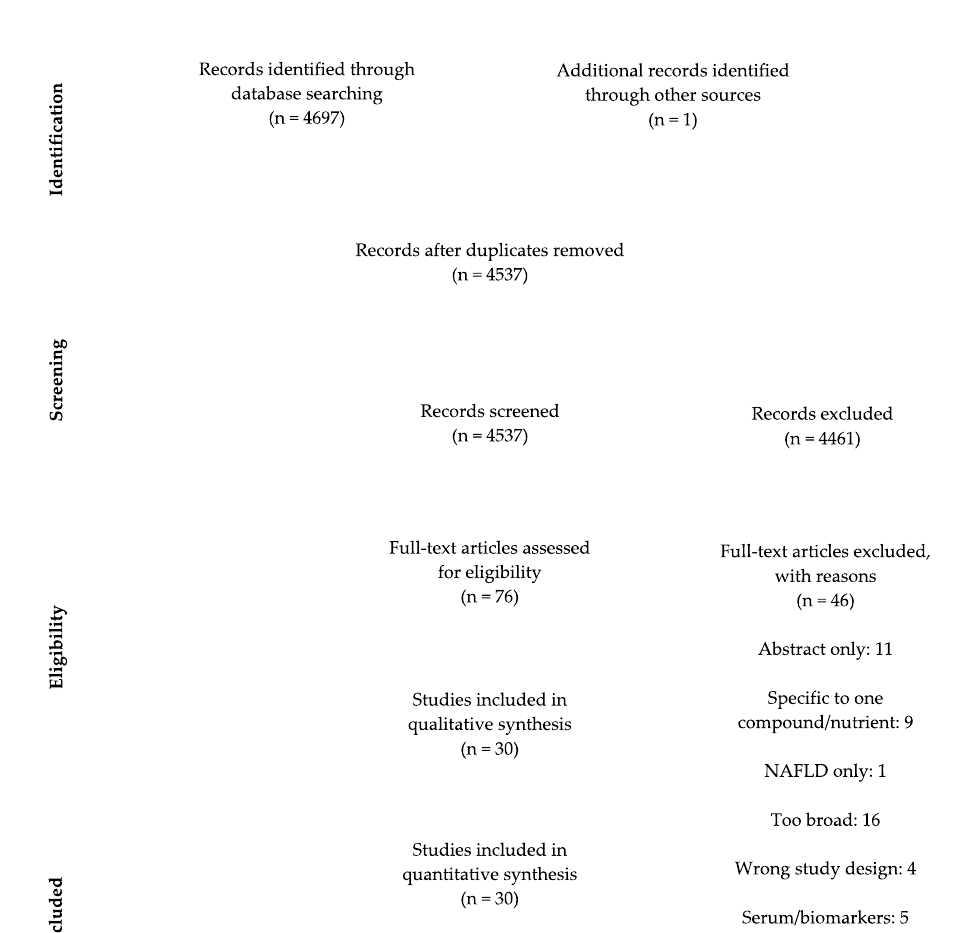
Figure 1. PRISMA flowchart of study selection process. NAFLD: Non-alcoholic fatty liver disease.